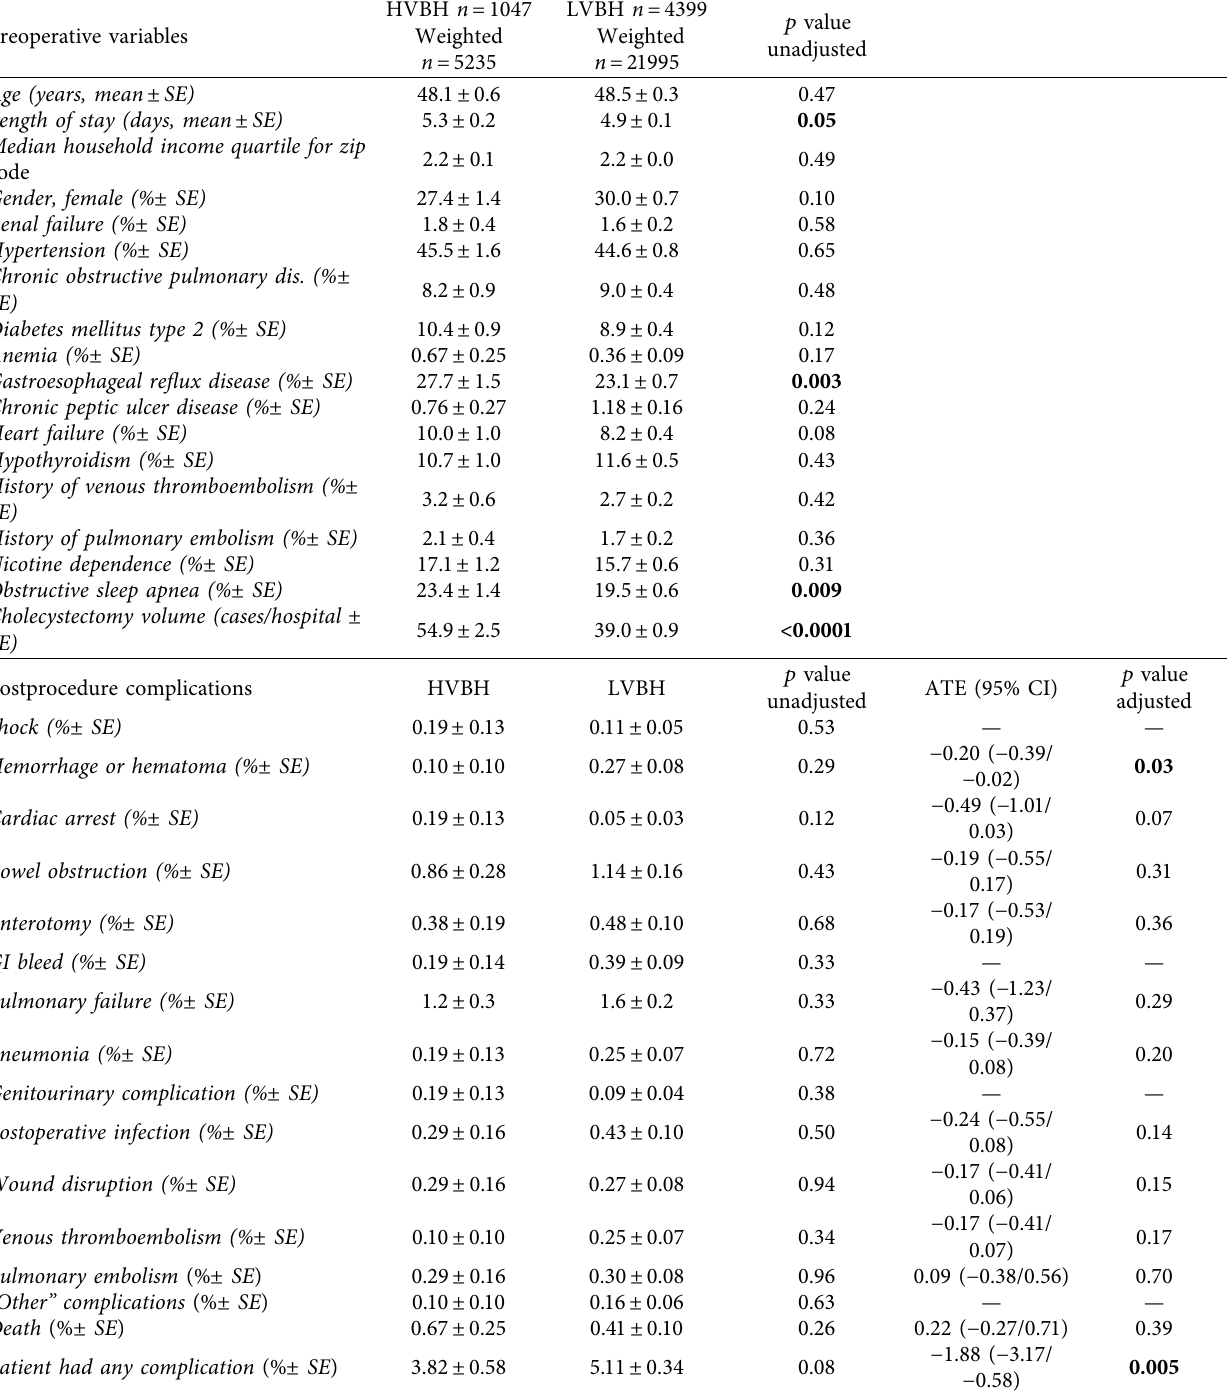
Table 3: Preoperative comorbidities and postoperative complications of patients with morbid obesity undergoing nonelective laparoscopic